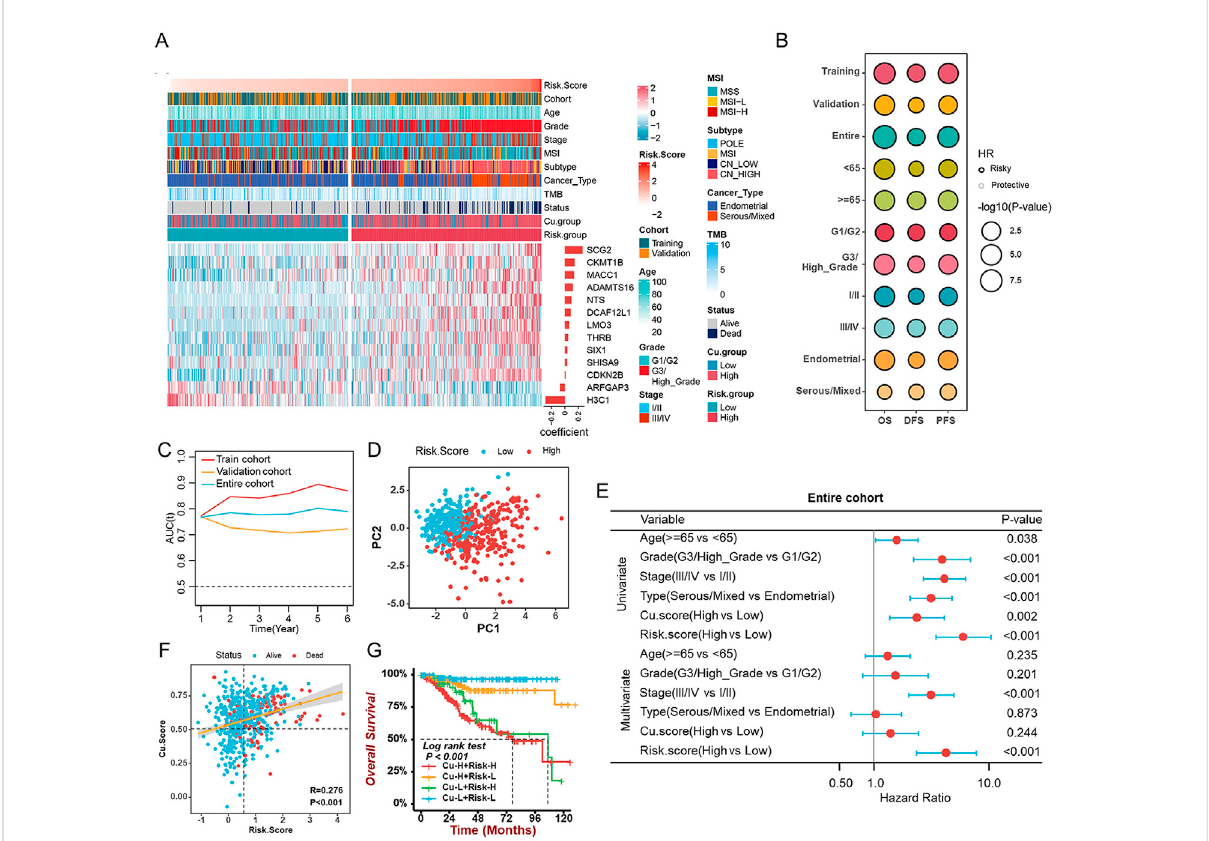
FIGURE 7 Construction and validation of the cuproptosis-related prognostic signature (A) . The heatmap revealing the correlations between clinicopathological characters and 13 cuproptosis-related prognostic genes (B) . The prognostic performance of the cuproptosis-related prognostic signature in different cohorts, age, grade, stage, and histological types. (C) The time-dependent AUC value in the training, validation, and entire cohorts. (D) ThePCArevealingthedifferencebetweenthehigh-andlow-riskgroupsbasedon13cuproptosis-relatedgenes. (E) .Theunivariate and multivariate Cox analyses suggesting the independent prognostic value of the Risk. Score in the entire cohort. (F) The correlation between Cu. Score and Risk. Score. (G) The survival analyses of patients with different Cu. Score combined with the Risk.